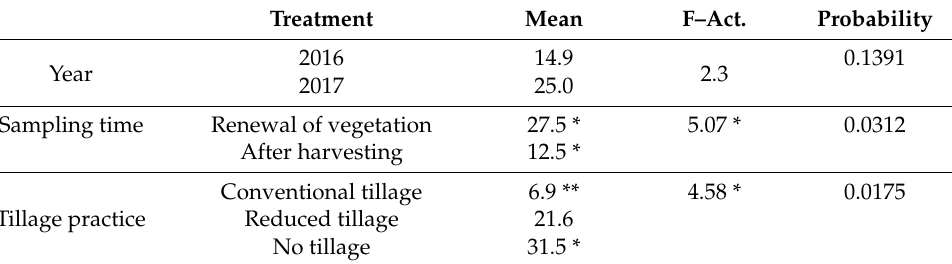
Table 1. Effect of year, sampling time and tillage practice on the mean value of F. graminearum DNA (pg F. graminearum DNA/ng of total DNA) content in the soil obtained by three-way ANOVA and Tukey’s mean separation test.